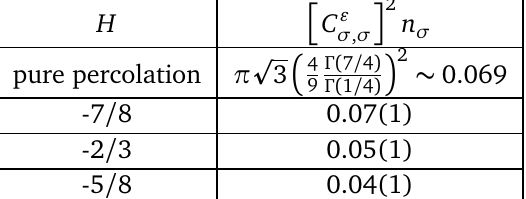
(cid:148) (cid:151) 2 C (cid:34) n σ . The percolation prediction was σ , σ